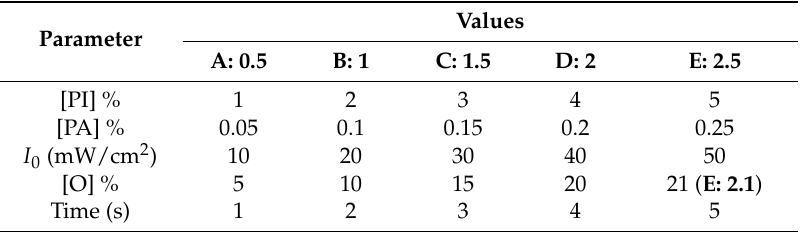
Table 4. Printing parameter evaluation using normalized value